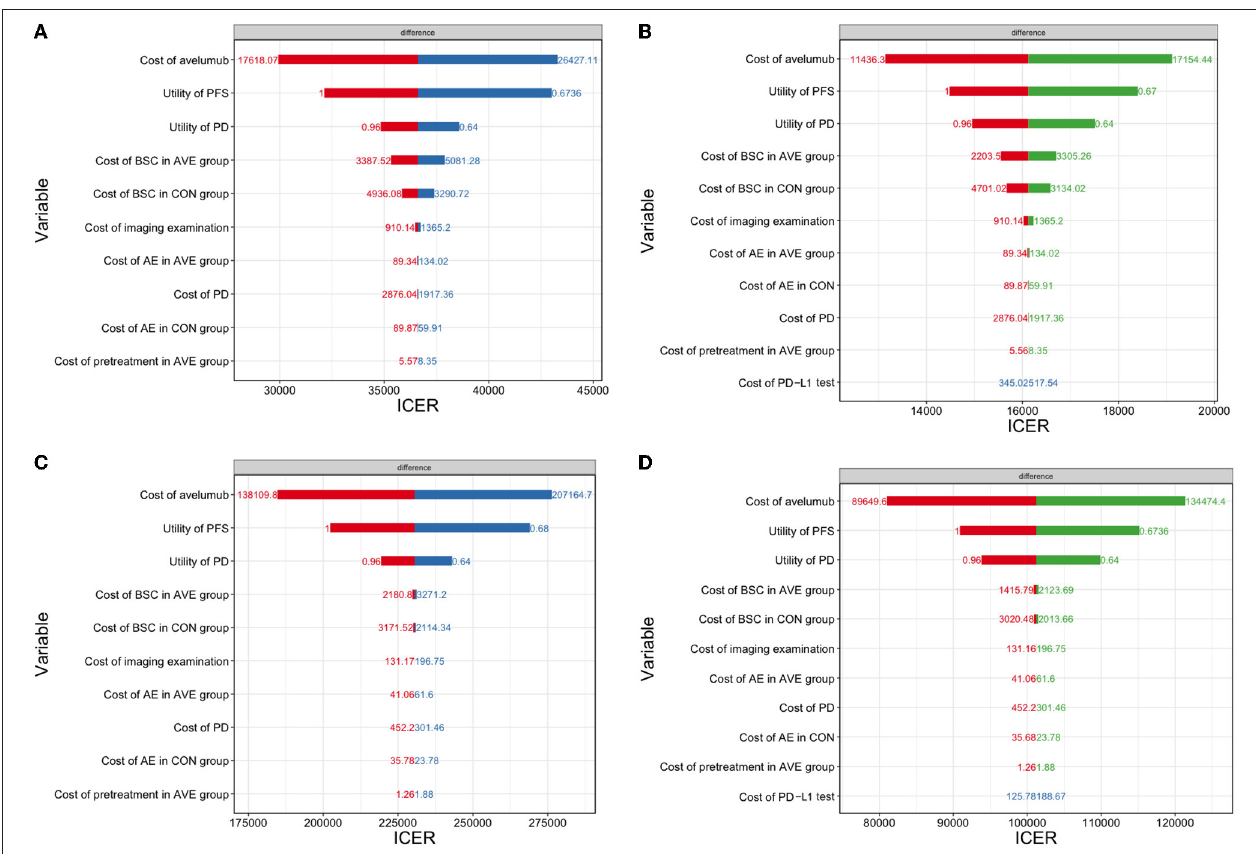
FIGURE 3 | A one-way sensitivity analysis was presented in the tornado diagram. The impact of different parameters on the ICER was listed. (A) The overall population in the US; (B) The PD-L1–positive population in the US; (C) The overall population in China; (D) the PD-L1–positive population in China. ICER, incremental cost-effectiveness ratio; PFS, progression-free survival; PD, progressive